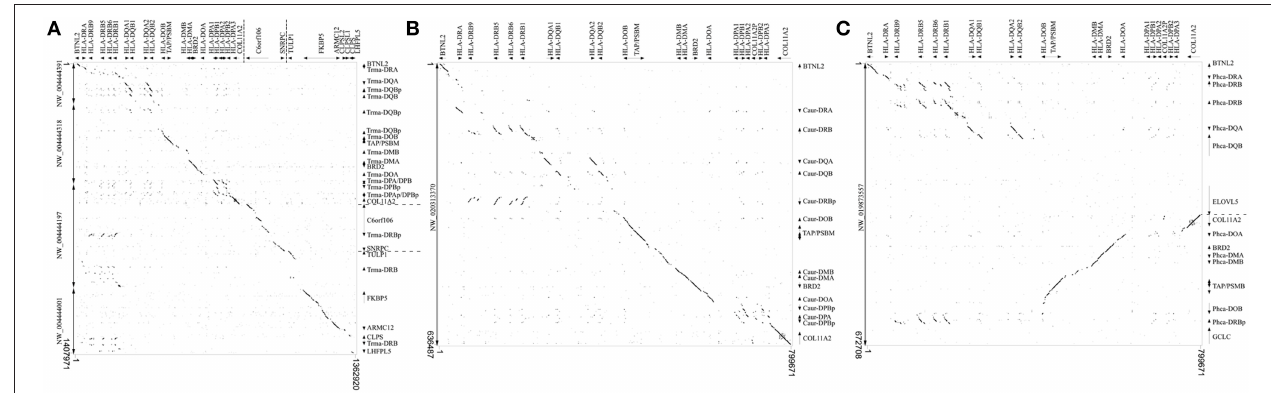
FIGURE 1 | Dot plot analyses of (A) Trichechus manatus , (B) Callorhinus ursinus , and (C) Physeter catodon scaffolds containing MHC class II genes, compared to the same region of the human genome. Human gene annotations are shown on the top of the graphs. For clarity purposes, extended class II region was reduced to include only key regions containing class II sequences; dashed lines on the annotation represent gaps. T. manatus sequences were in different scaffolds and were therefore concatenated for this